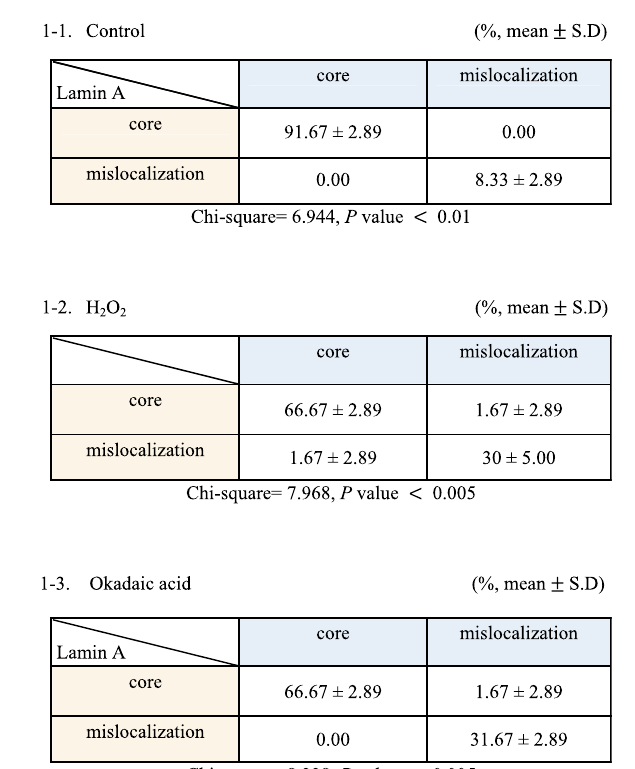
Table 1 Localization of Lamin A/C by BAF localization in the telophase chromosome core